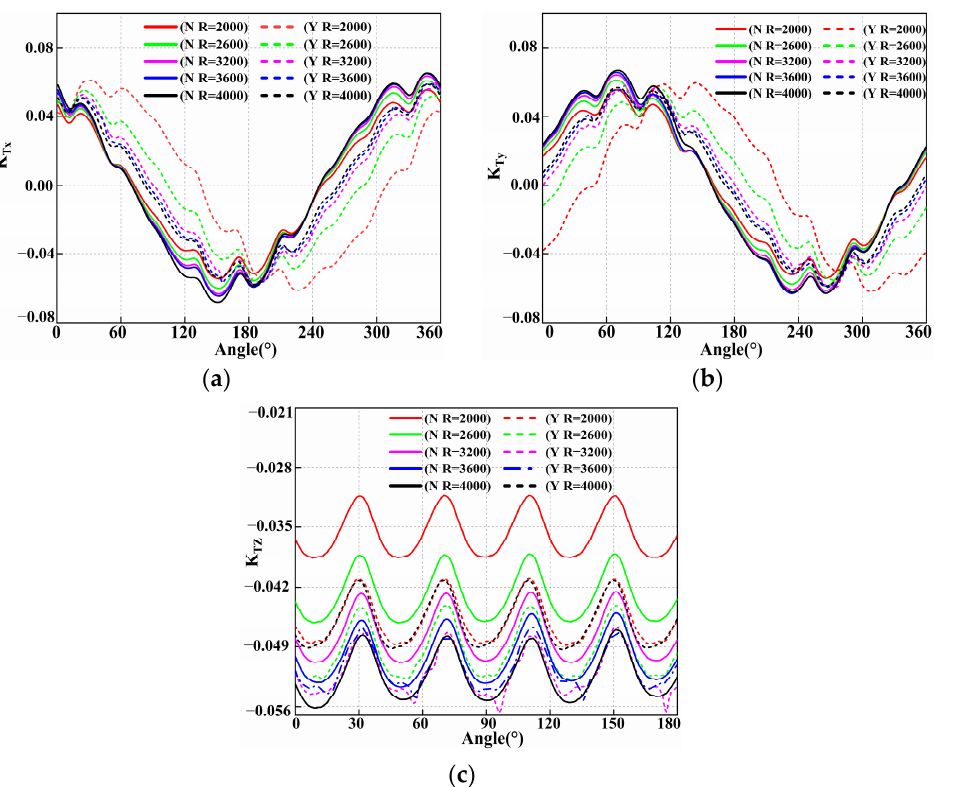
Figure 12. Bearing force of a single-blade under different conditions. ( a ) Difference of K TX at different rotating speeds. ( b ) Difference of K TY at different rotating speeds. ( c ) Difference of K TZ at different rotating speeds.